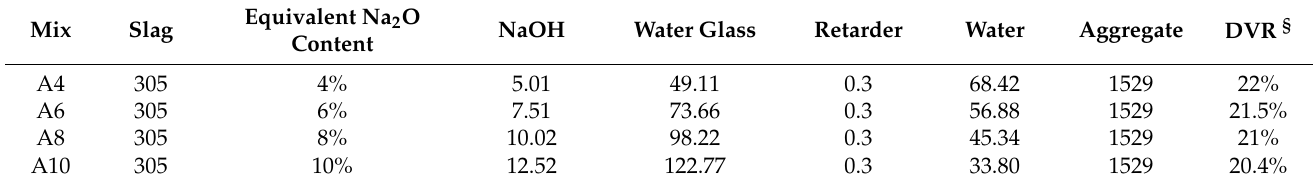
Table 4. Mix design of pervious concrete (kg/m 3 ).